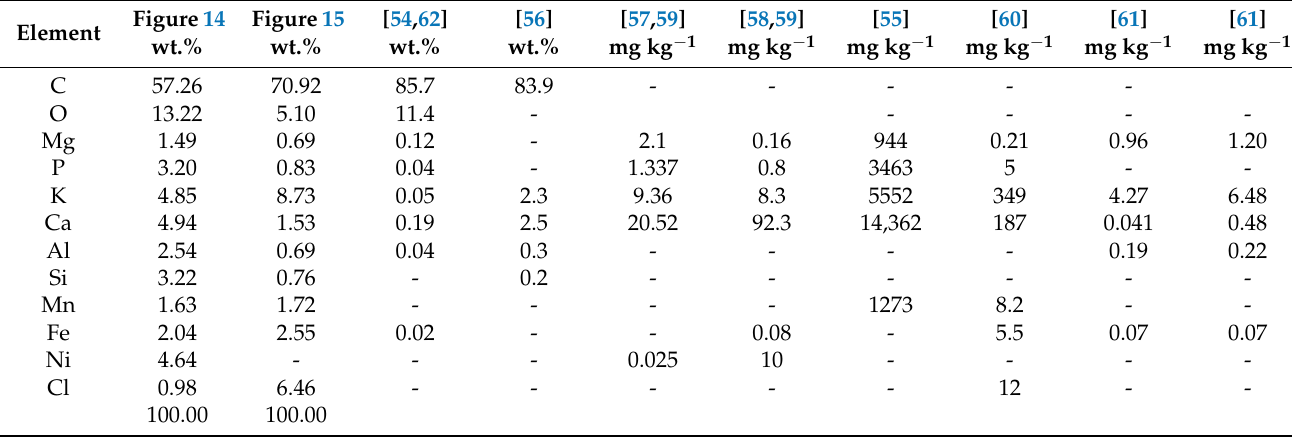
Table 8. Elemental analysis of wood biochar and comparison to other